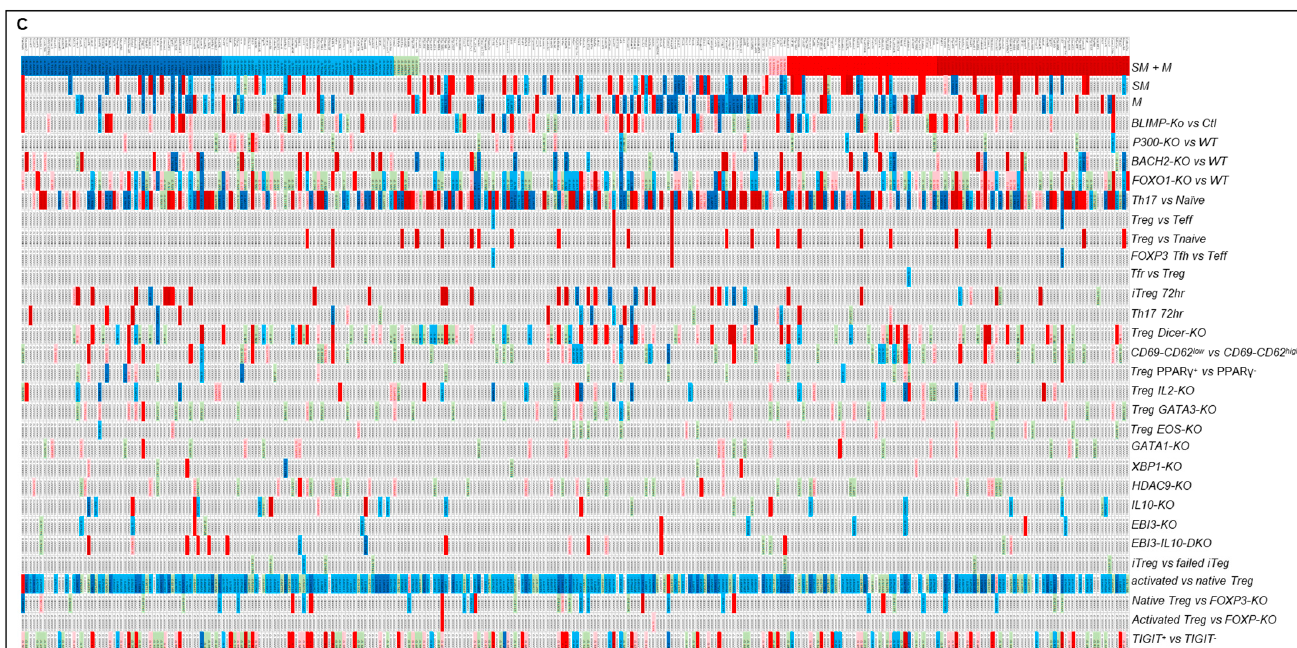
Figure 8. ( A ) Flow chart of biclustering heat map generation. ( B ) The expressions of cigarette smoke plus morphine (SM + M) modulated 304 transcription factor (TF) genes in Tregs were regulated in 28 transcriptomic datasets (cutoff: l FC l > 1). Of note, the 16 datasets with significant modulation of the expressions of more than 10 TFs were highlighted in red including BLIMP-KO, BATCH-KO, FOXO1-KO, Th17, Treg, iTreg 72 h, Th17 72 h, Treg Dicer, CD69-CD62 Low , Treg IL2-KO, IL10-KO, EBI3-KO, EBI3-IL-10-DKO, activated Treg, native Treg, and TIGIT + vs. TIGIT — . ( C ) Biclustering heat map of the expressions of cigarette smoke plus morphine (SM + M) significantly modulated TF genes in Tregs (304 IPA annotated TFs) with p < 0.05 from three comparisons). The list of 304 TFs were used to match to other 28 Treg datasets. These results indicated that SM + M specifically reshaped Tregs transcriptomes were not only significantly different from that of smoke treatment (SM specific), morphine treatment (M specific), Treg versus (vs.) T effectors (Teff), Treg vs. naïve, but also different from that of the Tregs from 28 Treg microarray datasets including BLIMP1-KO Tregs (GSE27143), p300-KO Tregs (GSE47989), BATCH2-KO Tregs (GSE45975), FOXO1-KO Tregs (GSE40657), T helper 17 (Th17) vs. naïve, Treg vs. Teff, Treg vs. T naïve, FOXP3 Tfh vs. Teff, Tfr vs. Treg), iTreg (72 h), Th17 (72 h) (GSE90570), Treg Dicer-KO (GSE11818), CD69-CD62L low (activated T cell markers) vs. CD62 high (resting T cell marker) (GSE36527), visceral adipose tissue PPAR γ + vs. PPAR γ - (GSE37532), Treg pro-survival cytokine IL2-KO (GSE14350), GATA3-KO Tregs (GSE39864), Treg EOS-KO, GATA1-KO Tregs, XBP1-KO Tregs (GSE40273), HDAC9-KO Treg (GSE36095), IL10-KO Treg, EBI3-KO Tregs, EBI3 and IL10-DKO (GSE29262), iTreg vs. failed iTreg, activated Treg vs. native Treg, native Treg vs. FOXP3-KO, and activated Treg vs. FOXP3-KO (GSE14415), and TIGIT positive vs. negative Treg (GSE56299). The color keys indicate the value of log2 fold changes (FC) of the gene expression (significance); red ranges indicate upregulation of genes, and blue ranges indicate downregulation of genes. Abbreviation: vs.: versus; WT: wild-type; KO: gene-deficient, knockout; DKO: double gene KO; Ctl: